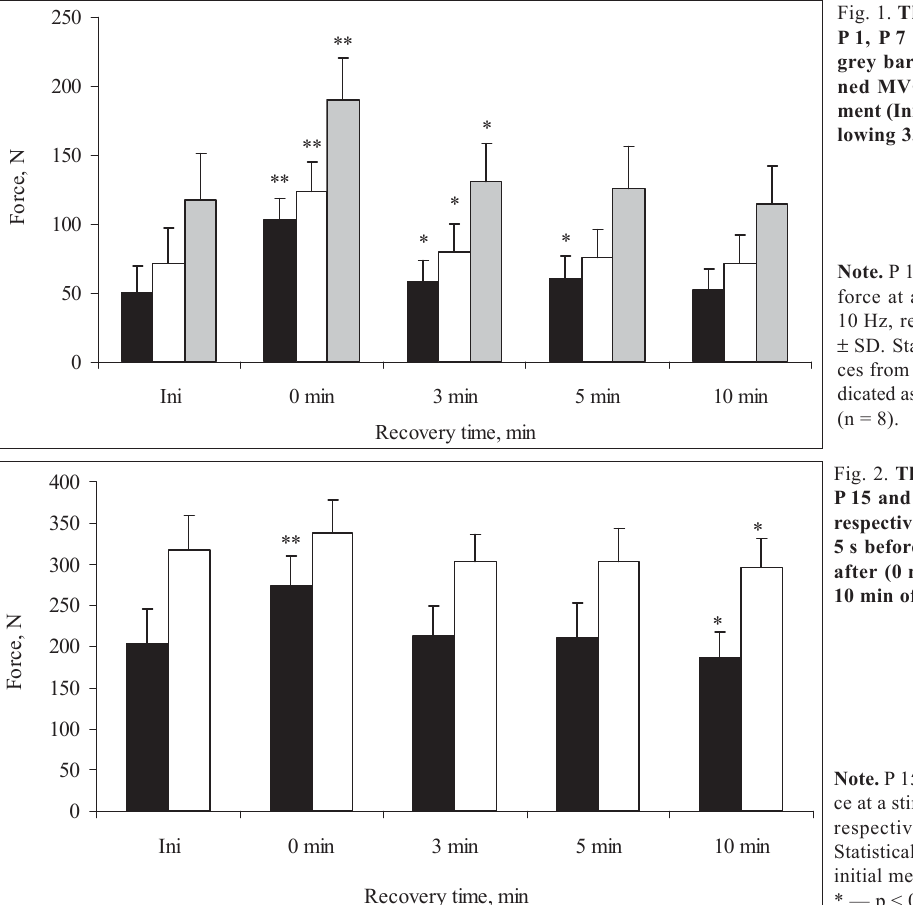
Note. P 15, P 20, muscle contraction for- ce at a stimulation rate of 15 and 20 Hz, respectively; Values are means ±